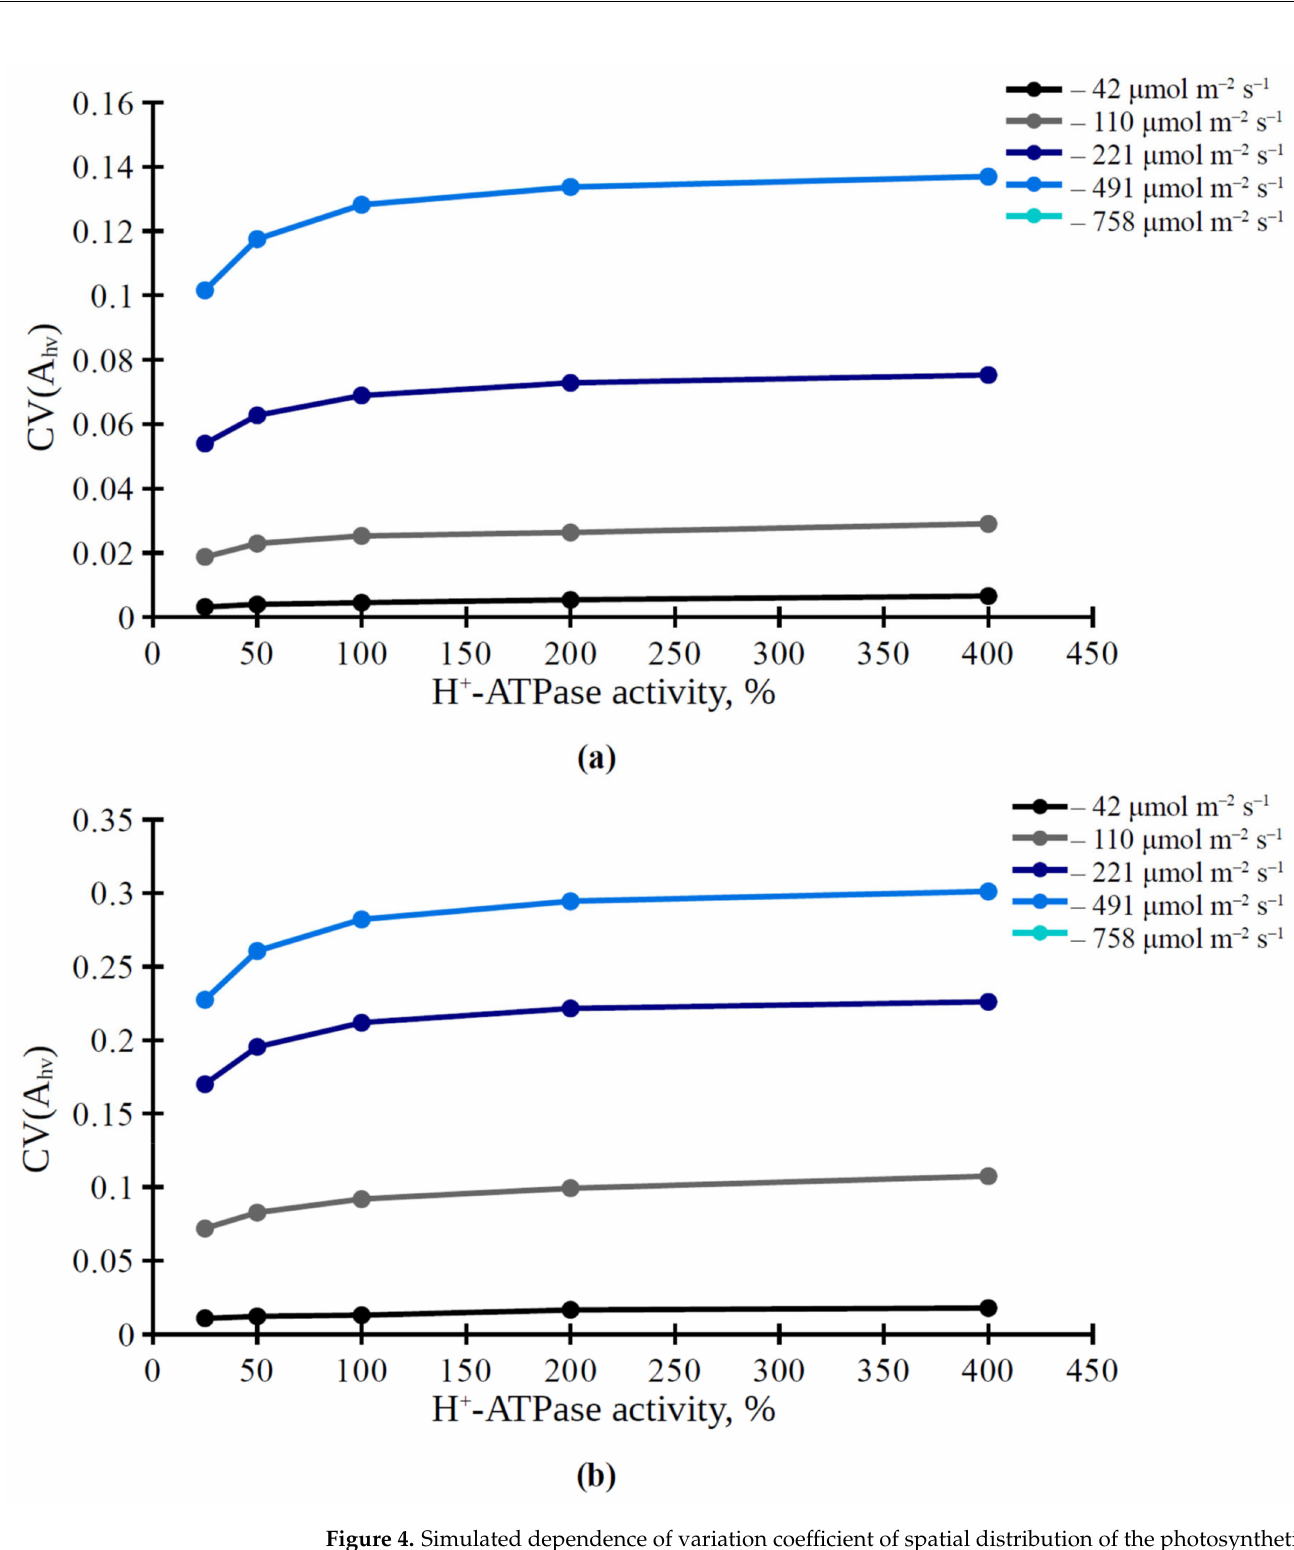
Figure 4. Simulated dependence of variation coefficient of spatial distribution of the photosynthetic CO 2 assimilation rate (CV(Ahv)) on the H + -ATPase activity in variants with stomata located in center of 3 × 3 cells square ( a ) or in center of 5 × 5 cells square ( b ) under various intensities of PAR. Value of the H + -ATPase activity from our previous work [42] was used as